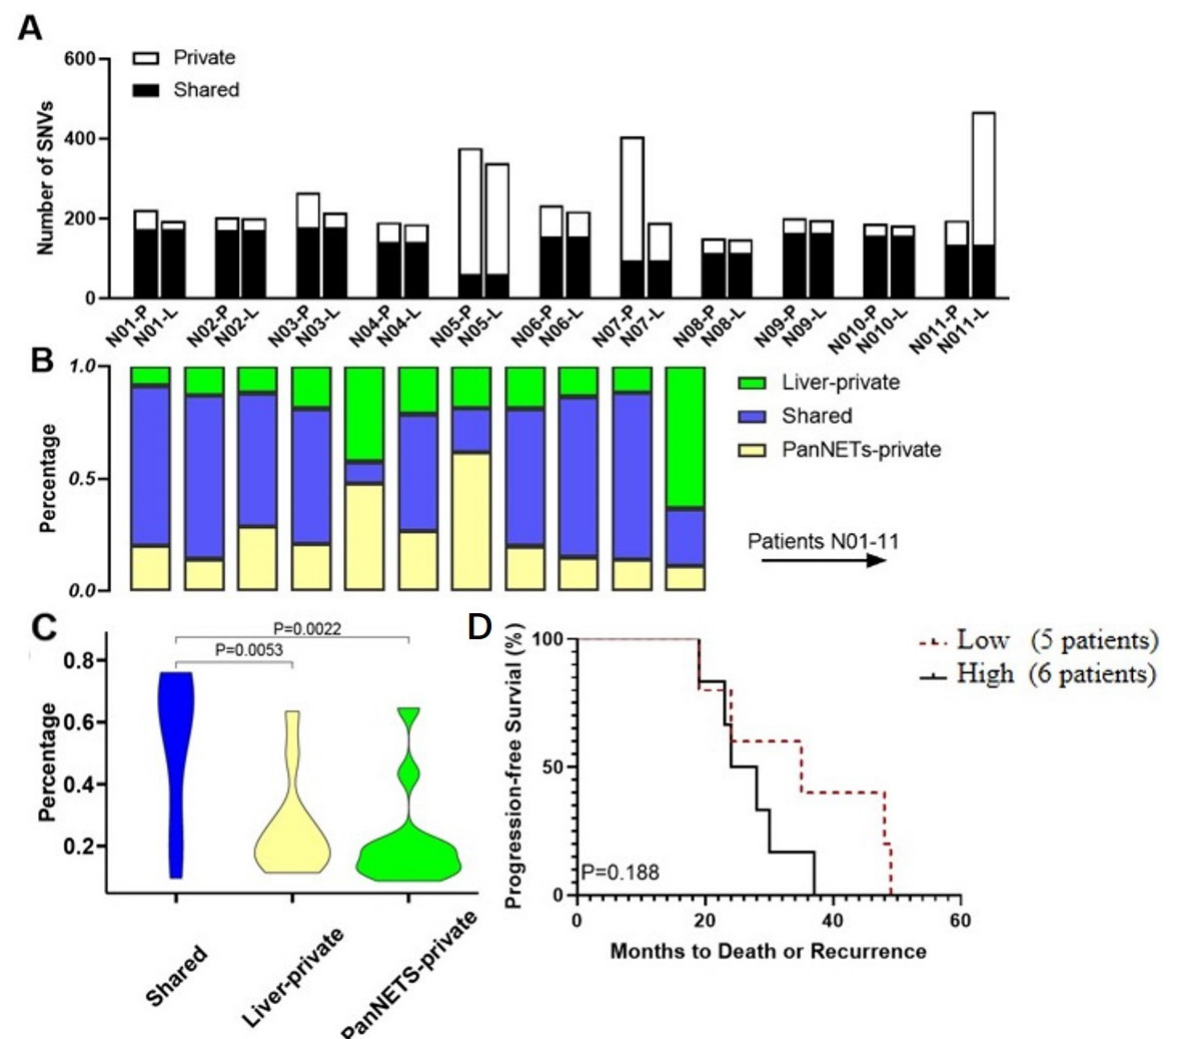
Figure 1. Genomic heterogeneity in paired primary pancreatic neuroendocrine tumors (PanNETs) and liver metastases. ( A ) The number of single nucleotide variants (SNVs) in each tumor tissue is shown. ( B ) The percentage of identified SNVs that are shared or private in PanNETs and liver metastases. ( C ) Violin plots illustrate the statistical results of the relative percentage of shared, primary PanNETS-private and metastasis-private SNV. The p value was calculated by Student’s test ( t -test). ( D ) The Kaplan–Meier curve of progression-free survival (PFS) of the study patients stratified by a low ( n = 5) vs. high ( n = 6) proportion of common SNVs and indels. The p value was calculated by the log-rank